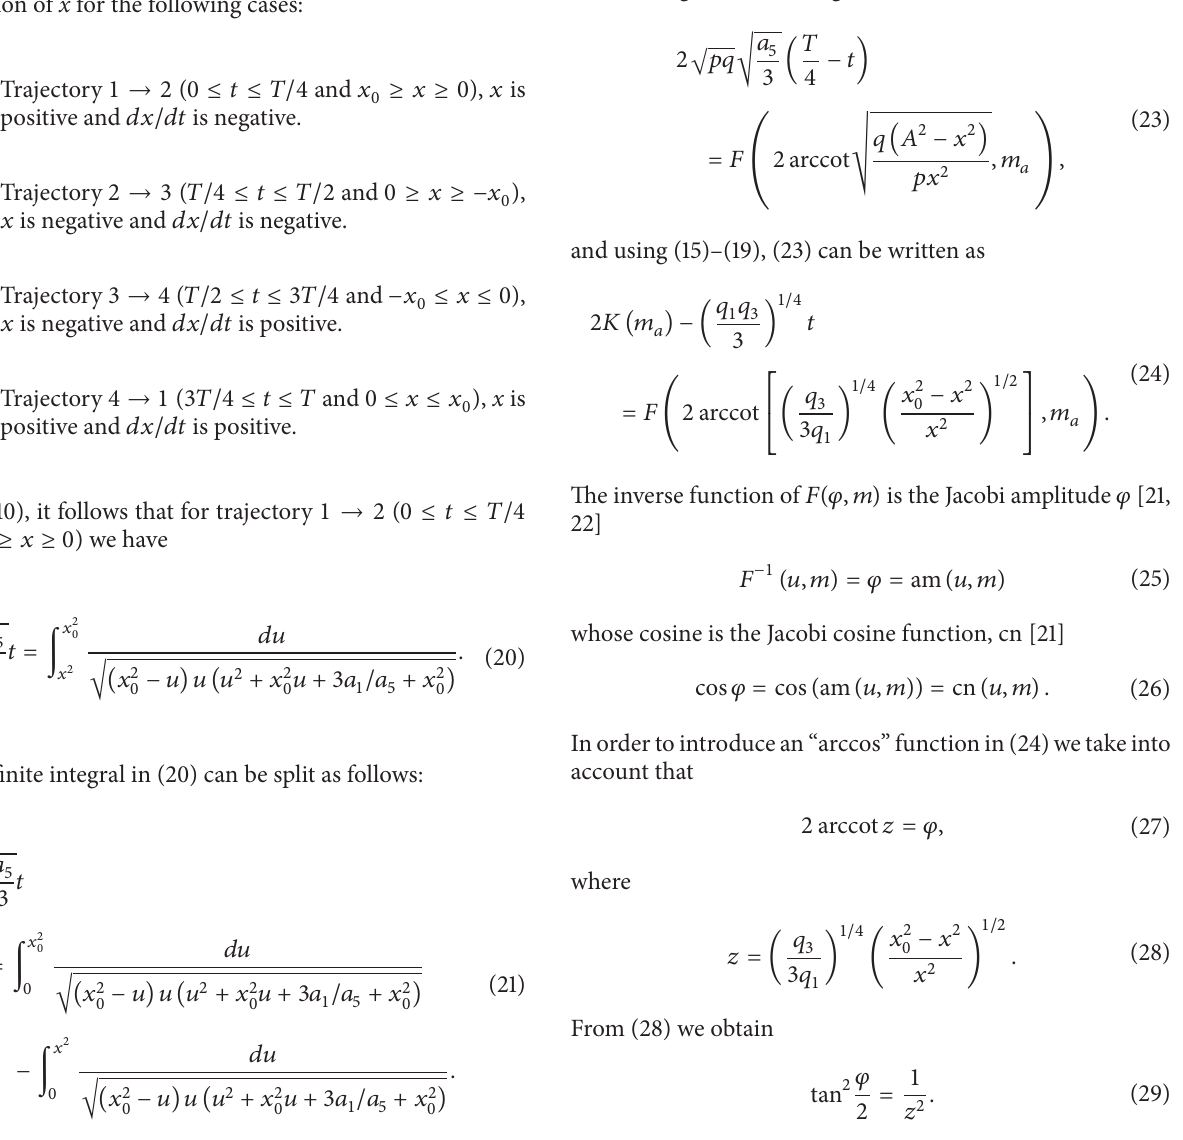
Figure2: Exactperiod T in(17)asafunctionoftheinitialamplitude 𝑎 = 1 and (a) 𝑎 𝑥 0 when 1 = 50 𝑎 5